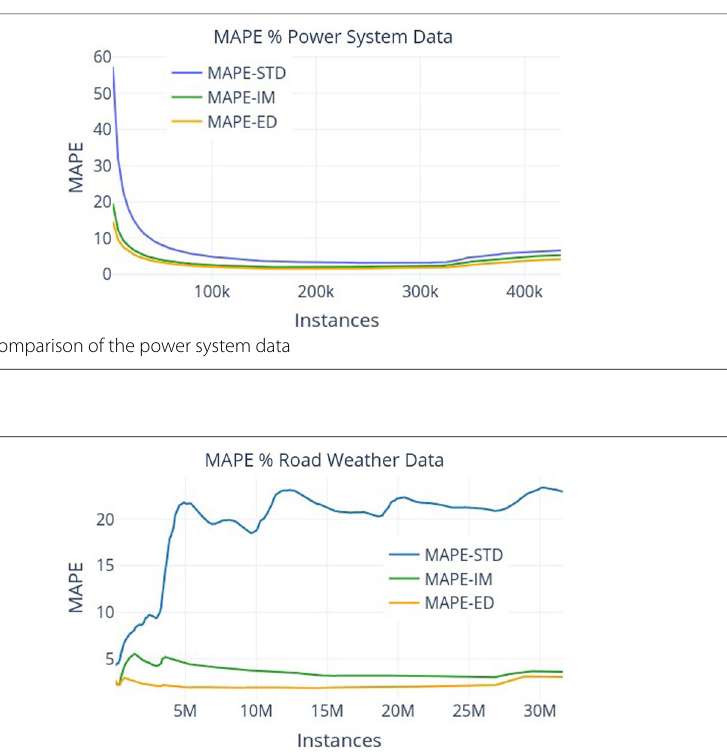
Fig. 9 MAPEs of the road weather